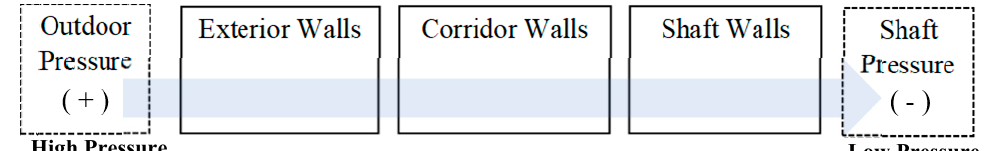
Figure 2. Illustration showing the airflow through building compartments when vertical shafts are subject to stack pressure differentials.